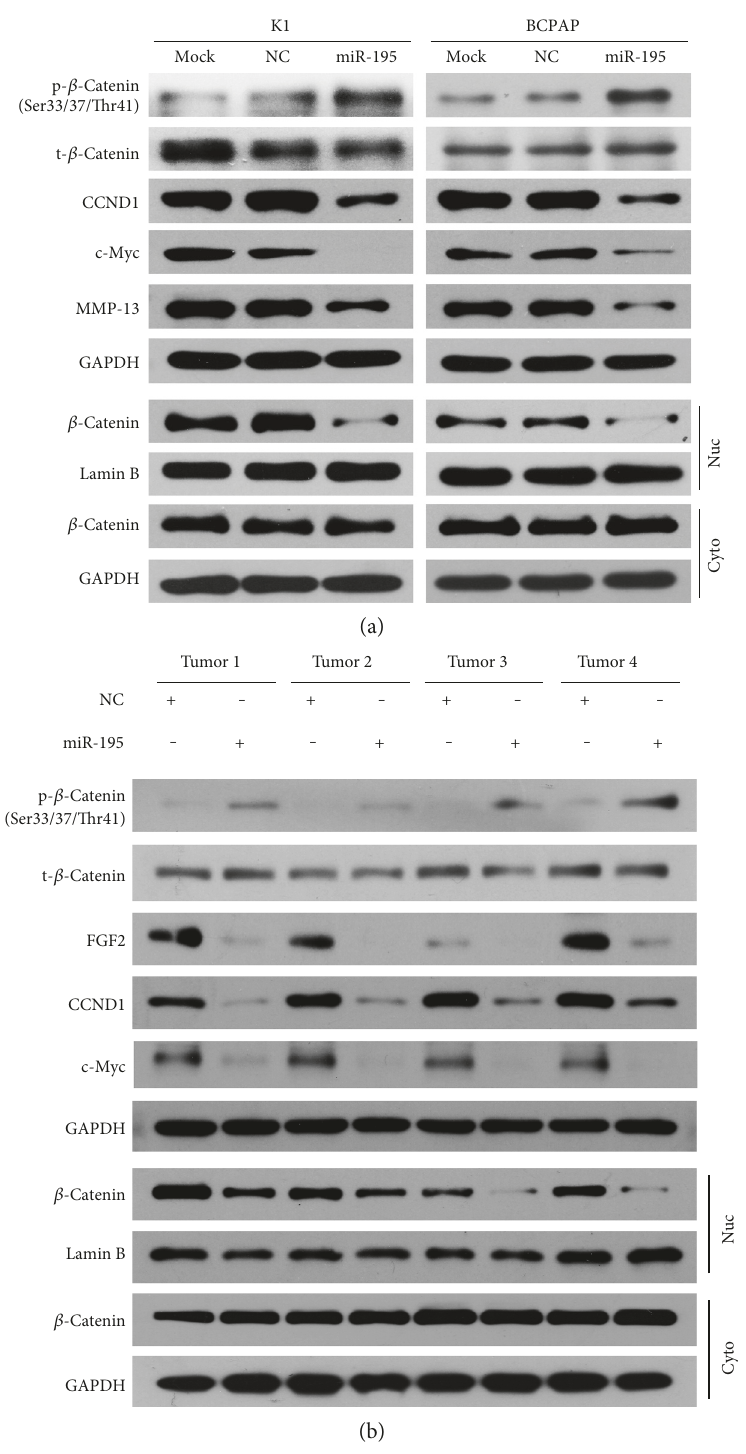
Figure 7: MiR-195 suppresses the Wnt/ β -catenin pathway in PTC cells and xenograft tumors. (a) Western blotting analysis of proteins involved in Wnt/ β -catenin pathway and MMP13 in PTC cells. The phosphorylation of β -catenin at Ser33/37/Thr41 sites increased in miR-195 overexpressing K1 and BCPAP cells. CCND1, c-Myc, MMP13 proteins, and nuclear β -catenin declined while cytoplasmic β -catenin almost unchanged after miR-195 transfection. (b) Expression pro fi le changes of CCND1, FGF2, and proteins involved in Wnt/ β -catenin pathways in xenograft tumor tissues. The miR-195 overexpression group demonstrated increased phos- β -catenin and decreased nuclear β -catenin. The expression levels of CCND1, FGF2, and c-Myc proteins were signi fi cantly reduced in the miR-195 group compared with the NC group. Tumors 1, 2, 3, and 4 are from four di ff erent mice. Lamin B and GAPDH presented as control. Nuc: nuclear; Cyto: